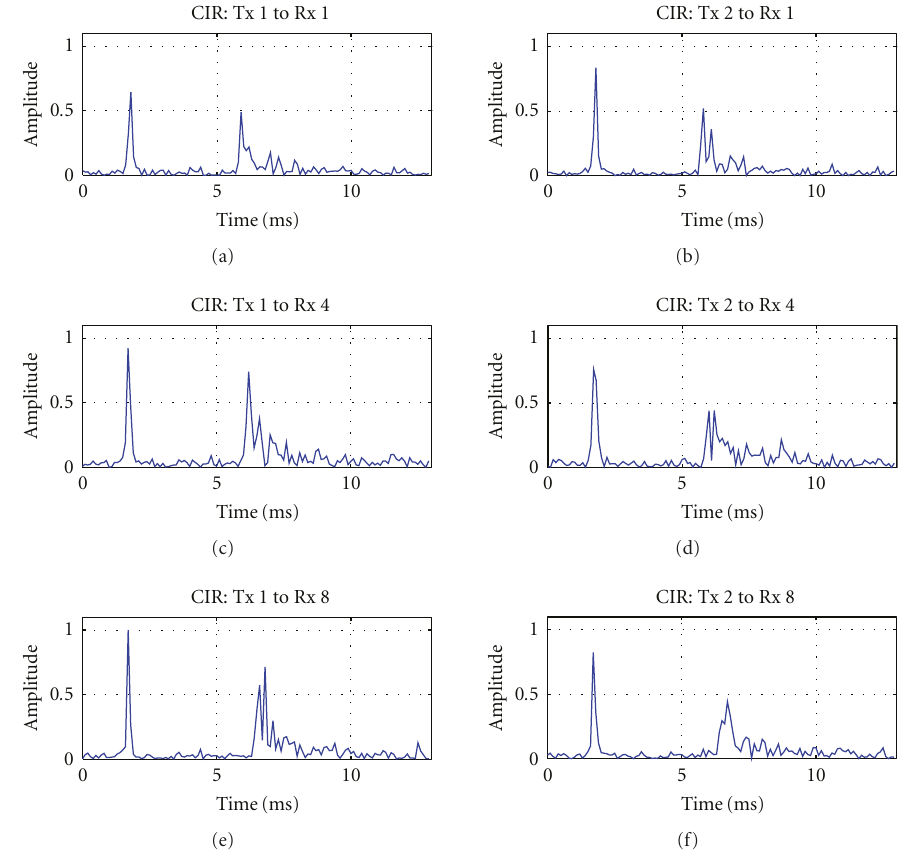
Figure 5: Estimated channel impulse responses for two-transducer eight-hydrophone transmission with BPSK modulation.